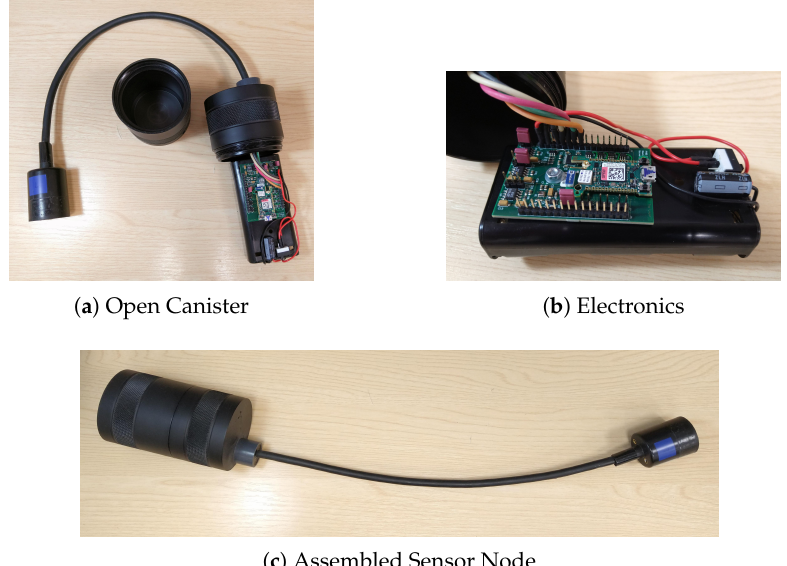
Figure 18. USMART Sensor Node. ( a ) Opened canister showing the electronics and battery holder. ( b ) Close up of the electronics mounted on the battery holder. Showing the custom power manage- ment and sensors PCB with the MicroPython PYBD connected. ( c ) Assembled node with 0.5m cable to the acoustic modem.